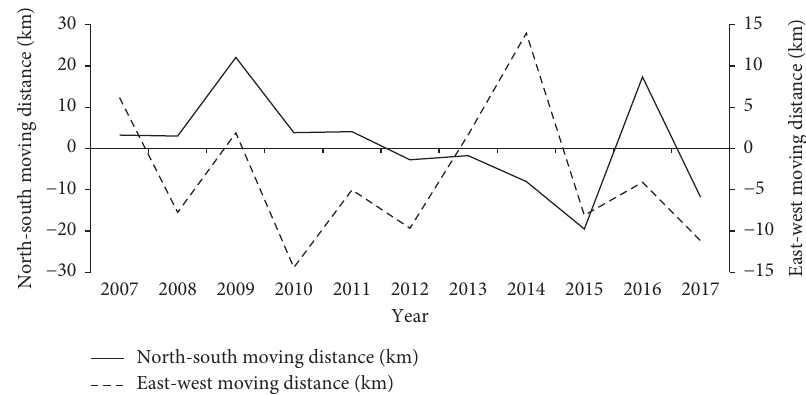
Figure 4: The offset distance of the center of gravity of marine economic efficiency between 2007 and 2017.